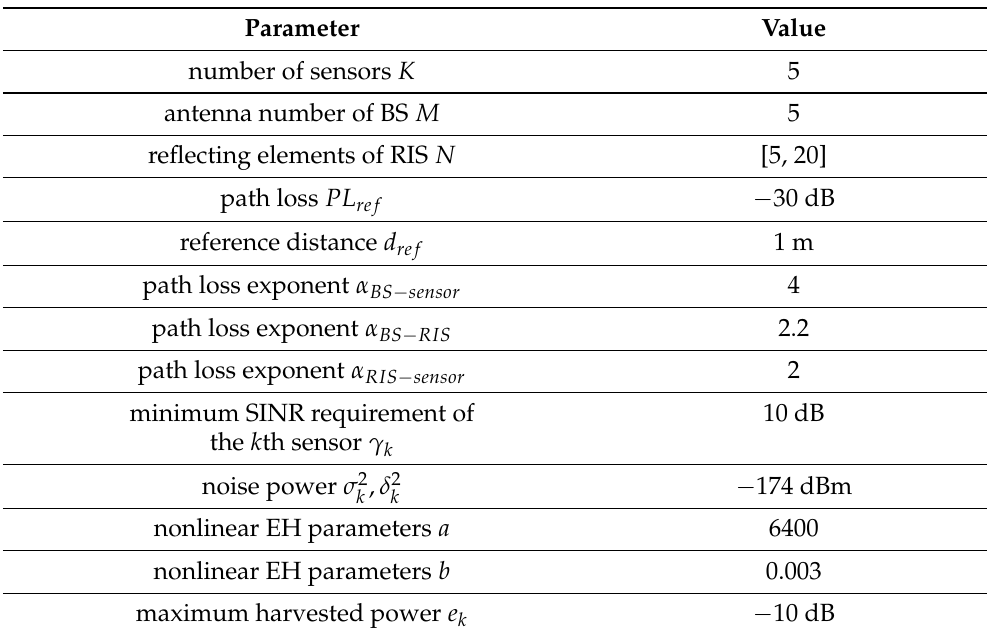
Figure 2. The simulation setup of the proposed system. Table 1. Parameter